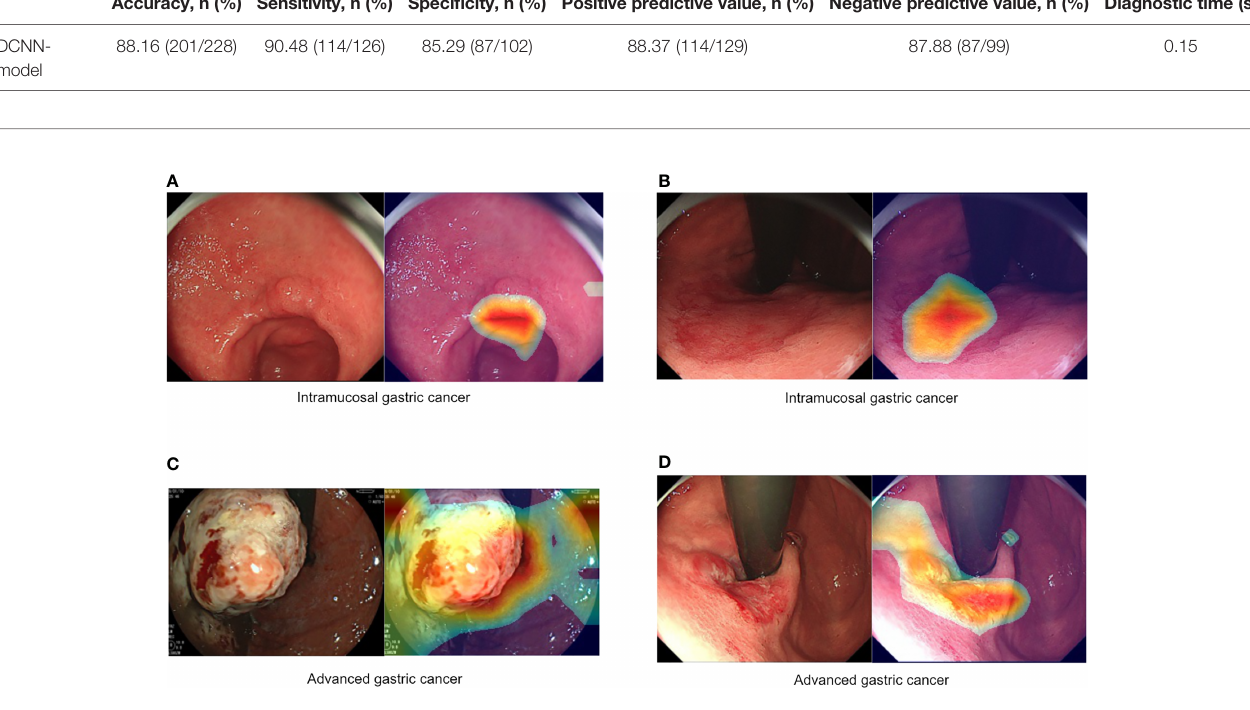
TABLE 1 | Performance of the DCNN Model for Diagnosis of Gastric Mucosal